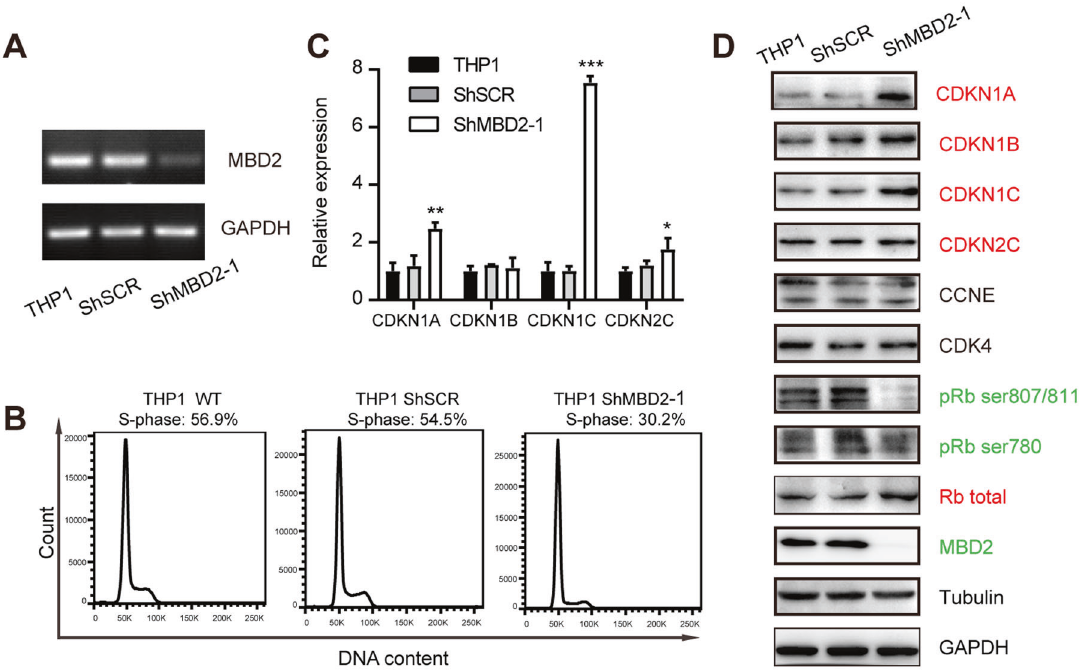
Fig. 5 Downregulation of MBD2 attenuates leukemogenesis in THP1 human AML cells by activating cell cycle inhibitors. A The expression of MBD2 transcripts was determined by qRT-PCR in parental THP1 and THP1 shSCR and shMBD2-1 cells. GAPDH was included as a loading control. B Typical fl ow cytometric pro fi les show representative cell cycle data from two independent experiments. The cell cycle was analyzed using PI staining. C qRT-PCR indicated the transcript level of cell cycle regulators in the depicted cells. Error bars, s.d. D Expression levels of typical cell cycle regulators in parental THP1, THP1 shSCR, and shMBD2-1 cells were determined by WB. GAPDH was used as an internal control. * P < 0.05, ** P < 0.005, and *** P <